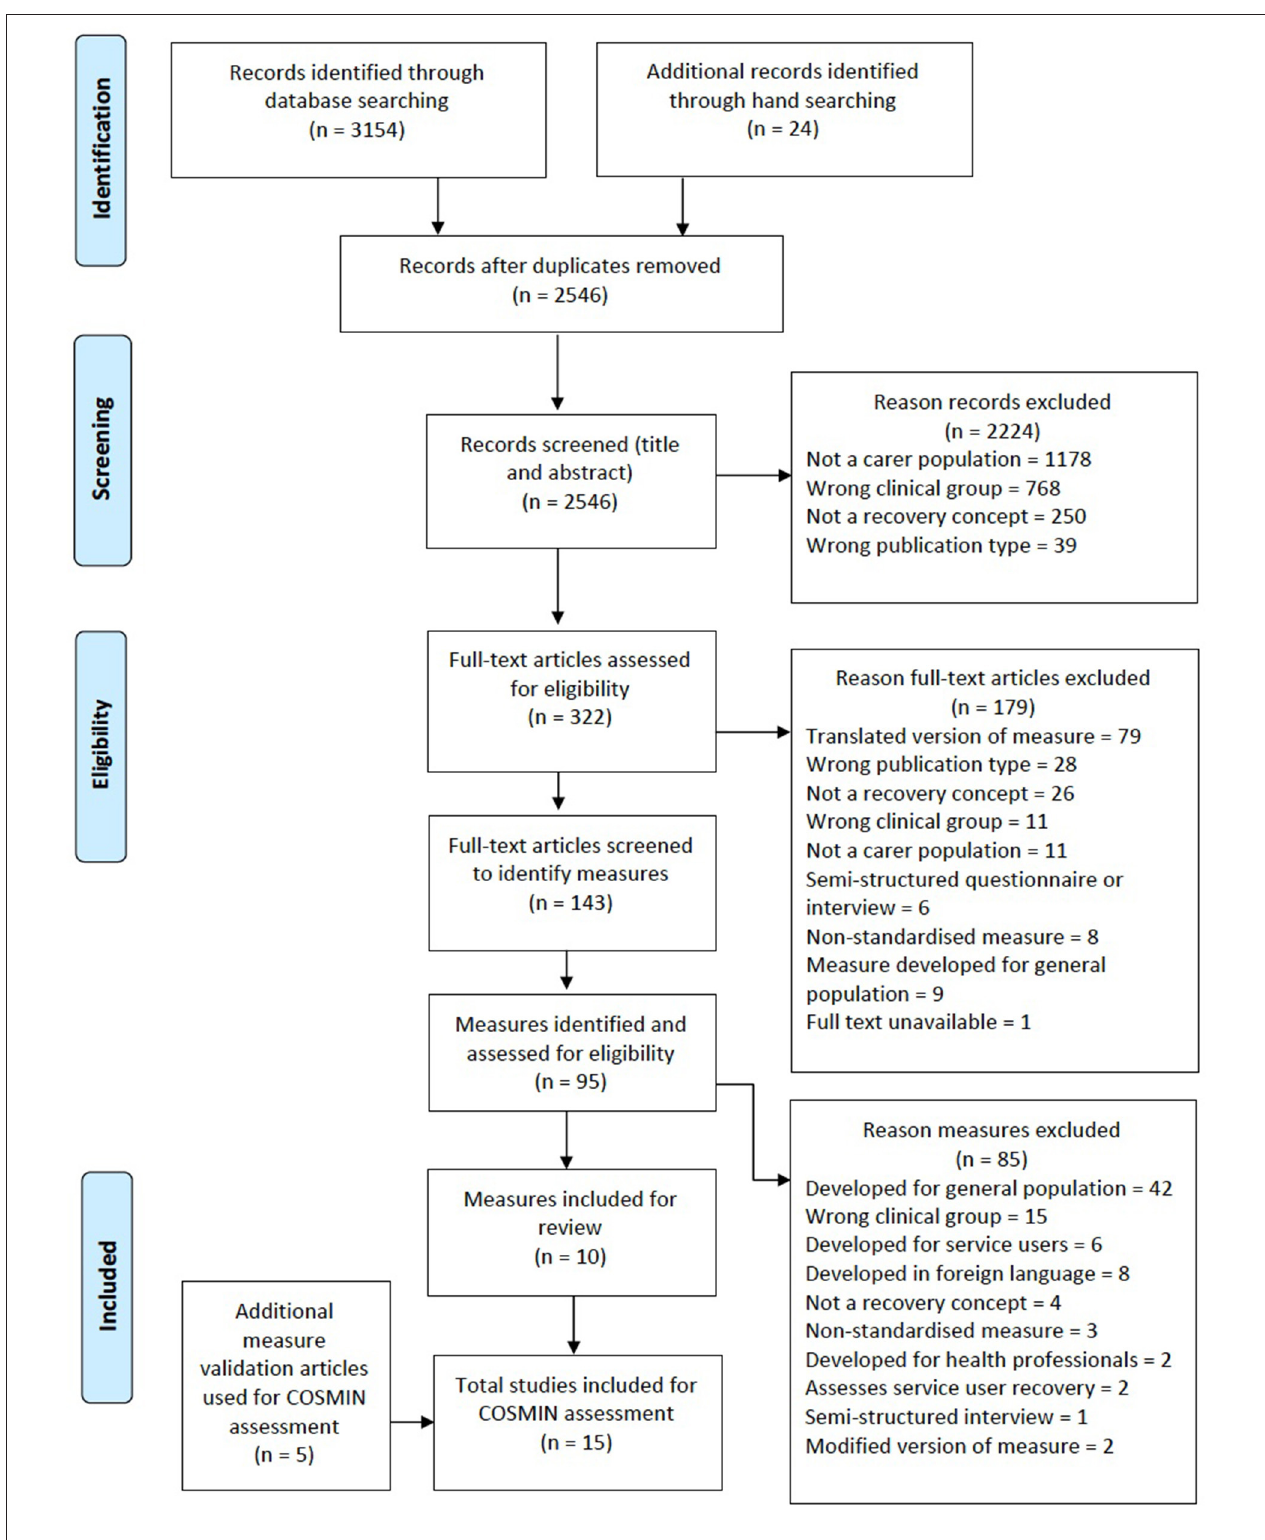
FIGURE 1 | Flow chart detailing the literature